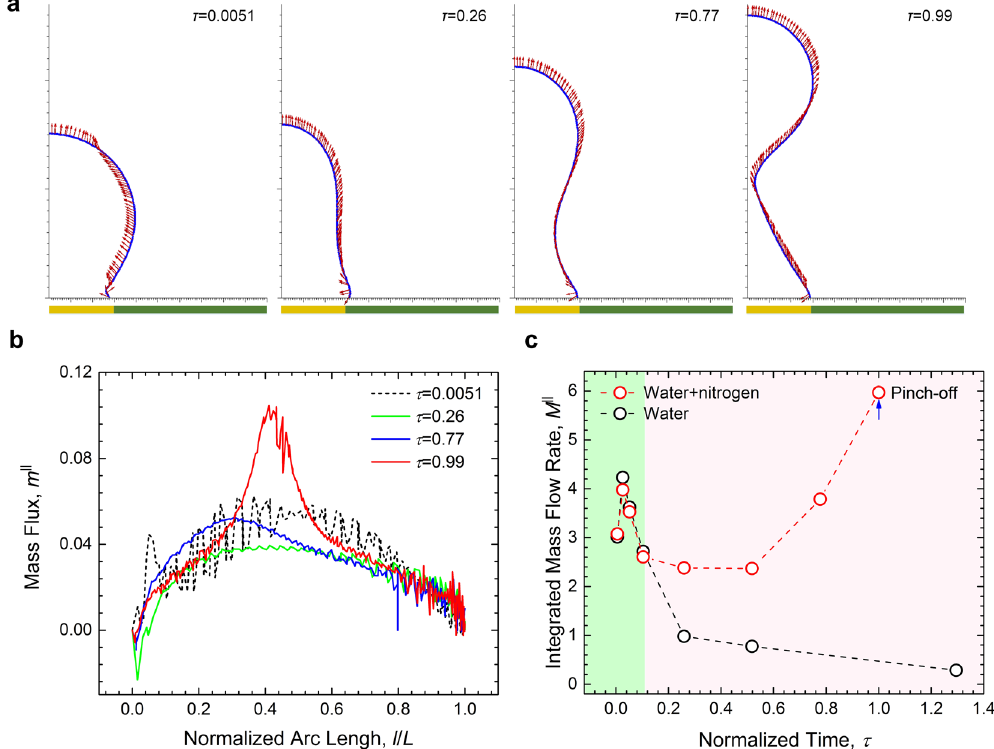
Figure 7. Simulated interfacial flow in the water-nitrogen system. ( a ) Evolution of the local velocity distribution at the bubble interface. The results show that as the bubble grows, the velocity vectors below the neck increasingly align with the bubble surface, which is thought to be driven by the strong surface stress difference between the gas-rich top and vapour-only bottom. Note that the bubble interface is evaluated at the isodensity level of ρ = 0.8 ρ l . Yellow strip: hydrophobic subregion ( θ e = 120°); green strip: hydrophilic subregion ( θ e = 10°). ( b ) Distributions of the mass flux tangent to the interface, m || , over the bubble surface (i.e., the normalized arc length by the total length of the bubble outline) during various stages of bubble growth. Driven by the significant thermocapillary effect, consistently strong Marangoni flow (tangent to the surface) prevails in the lower section of the bubble, which gradually weakens approaching the bubble cap. At the moment of pinch-off, the mass flux rises sharply around the neck region. ( c ) Total tangential mass fluxes integrated over the bubble interface, M || , versus nondimensional time, τ . Sustained by the ever-increasing surface stress gradient (due to the accumulation of nitrogen inside the bubble), M || strongly diverges nearing the eventual pinch-off. In contrast, in the single-component system, the mass flux along the bubble surface decreases rapidly over